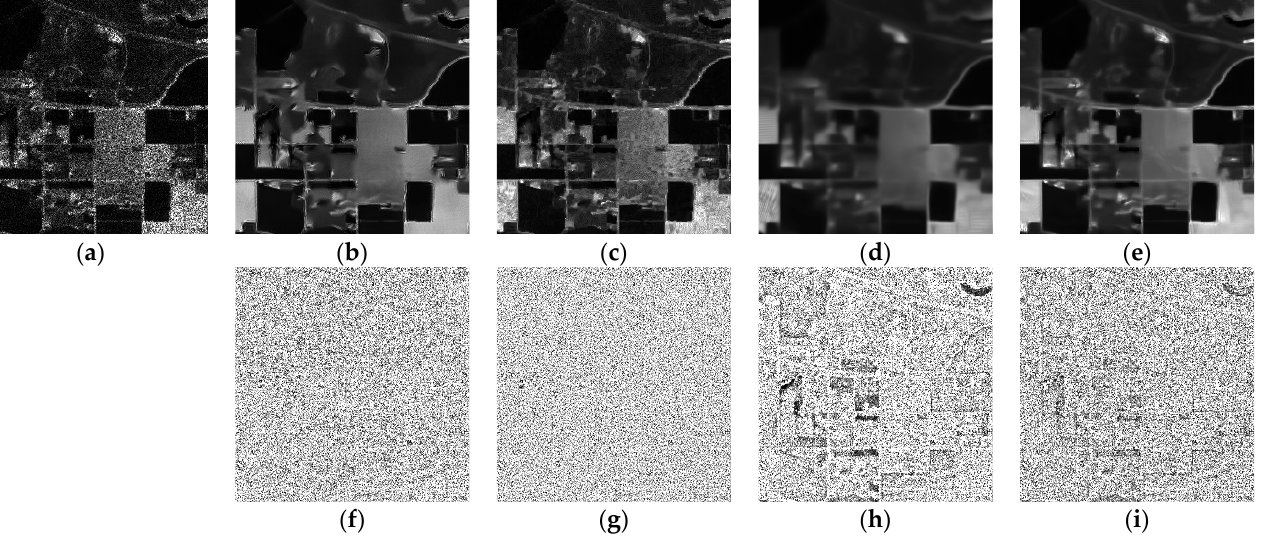
Figure 6. The results of the candidate despeckling methods on S1 ( L = 1), and the bottom row are the corresponding ration images. ( a ) Noisy image; ( b ) Probabilistic Patch-Based (PPB); ( c ) SAR-block matching 3D (SAR-BM3D); ( d ) Homomorphic Weighted Nuclear Norm Minimization (H-WNNM); ( e ) Guided Non-Local means (GNLM); ( f ) PPB; ( g ) SAR-BM3D; ( h ) H-WNNM; ( i ) GNLM. Table 1. FSIM, PSNR, and ENL of the selected despeckling methods.